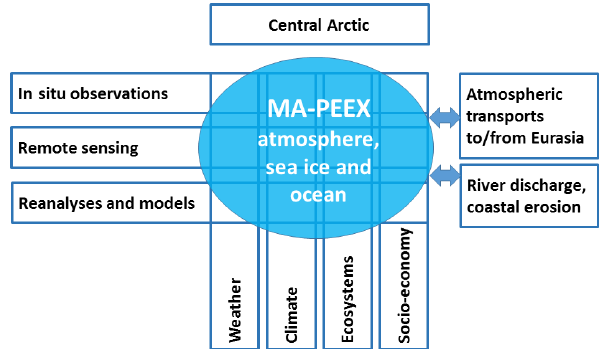
Figure 2. Schematic illustration of the marine Arctic component of PEEX